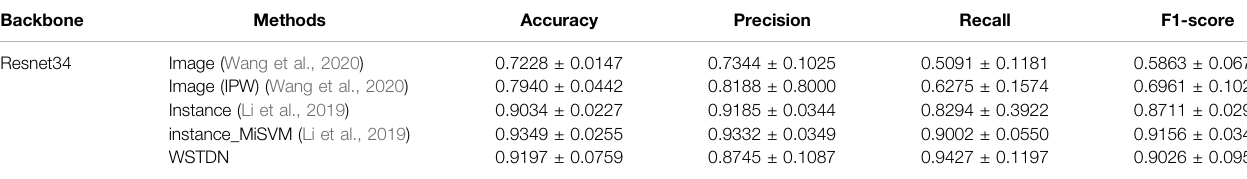
TABLE 1 | Performance comparison of different methods for tooth-marked tongue recognition. Backbone Methods